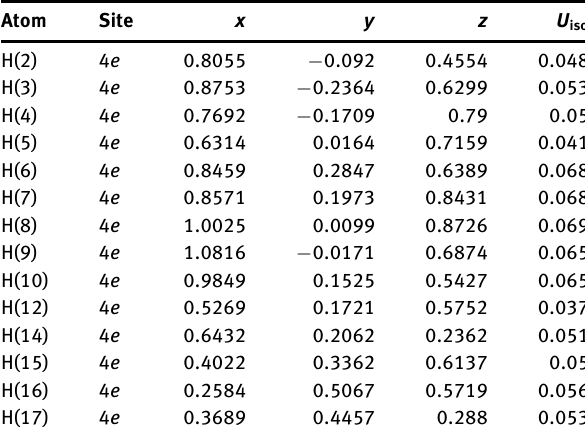
Table 2: Fractional atomic coordinates and isotropic or